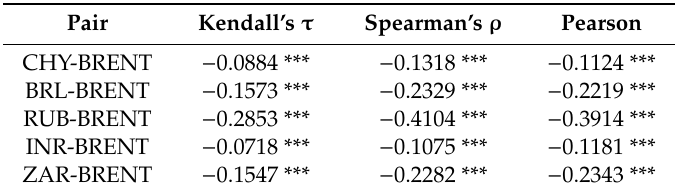
Table A3. Rank correlation and linear correlation.